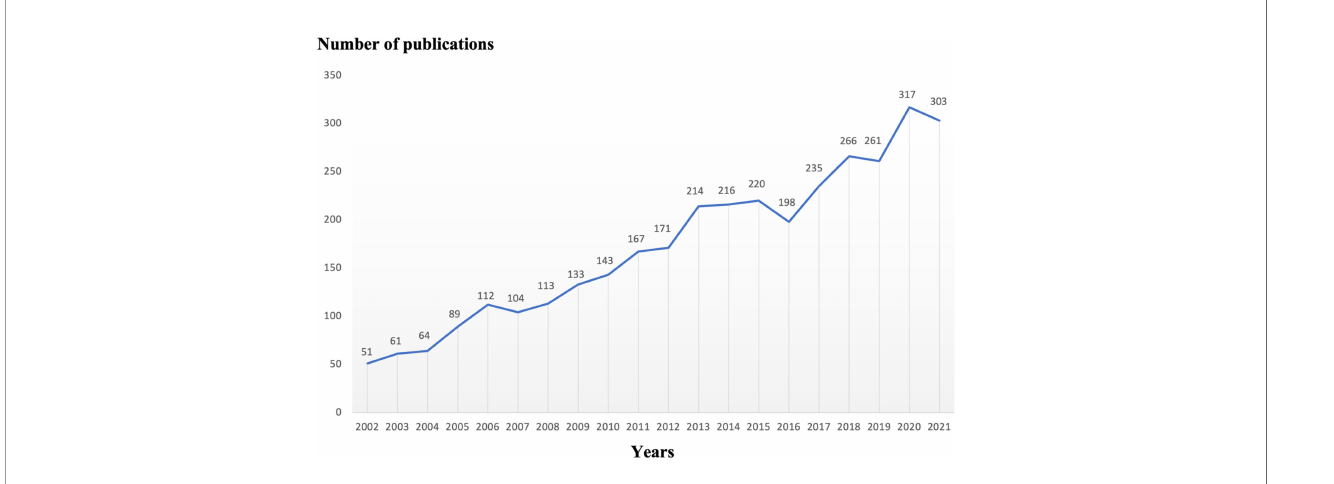
FIGURE 2 | Trends of osteoblasts-osteoclasts published in bone diseases research over the past 20 years.